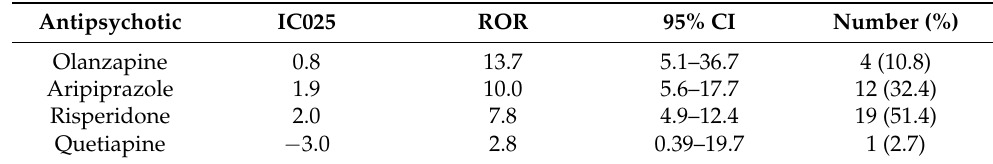
Table 6. Disproportionality analysis for main antipsychotics involved in reports of withdrawal in patients aged between 2 years and 11 years, ranked by